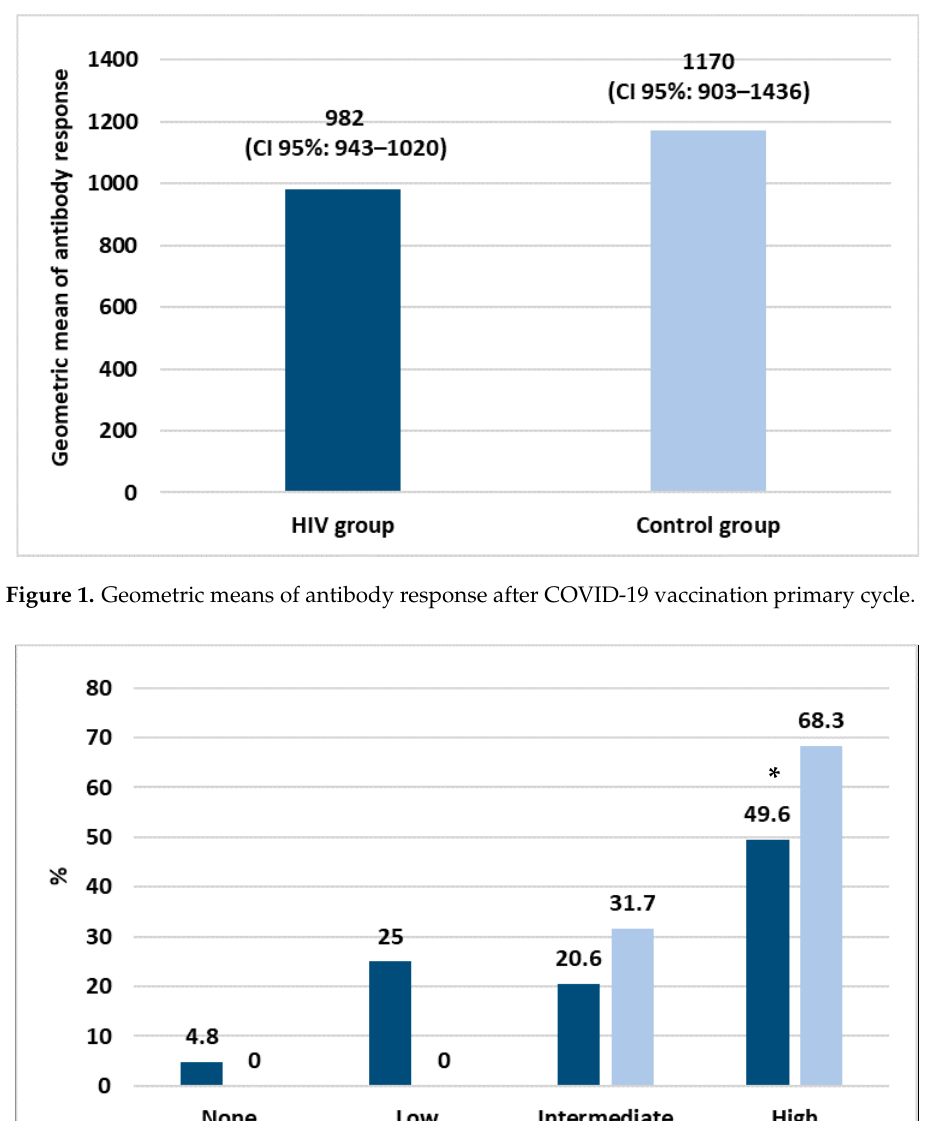
Figure 2. Intensity in the antibody response between the two studied groups, * p < 0.05.